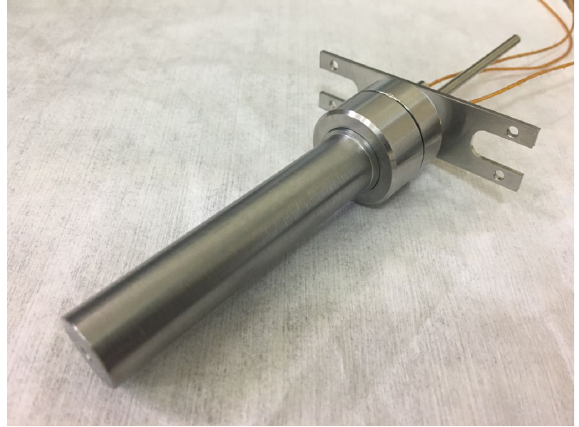
Figure 9. Novel coaxial–heater hollow cathode design with molybdenum cathode tube and keeper.